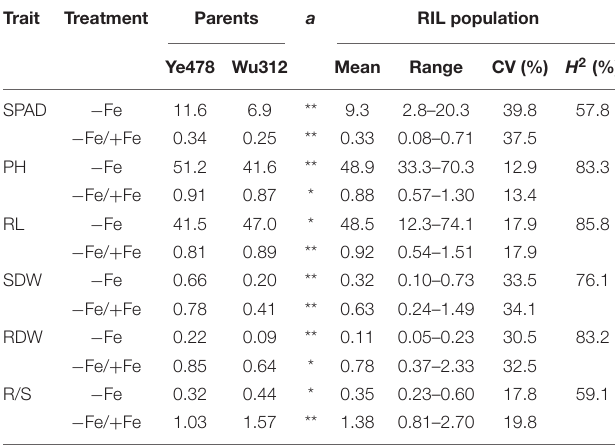
TABLE 1 | Statistical analysis of phenotypic variation in parents and their recombinant inbred line (RIL) population. Trait